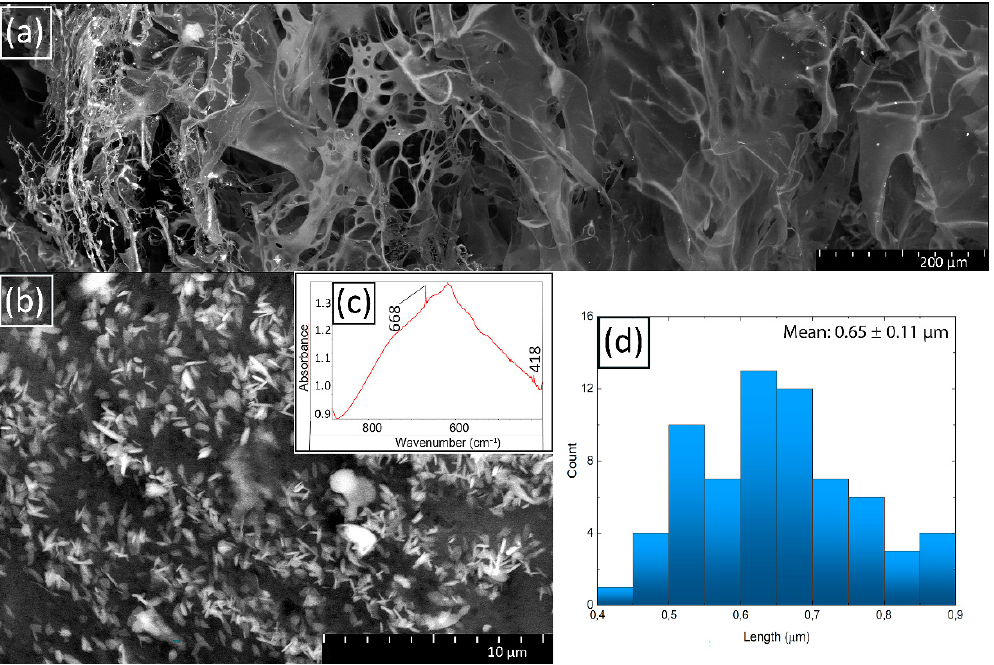
Figure 8. SEM-microphotographs of Cu/CS spherical gel sample (high molecular weight chitosan, 0.116 M, 300 µL) ( a ) cleavage; ( b ) surface; ( c ) part of FTIR spectra of Cu/CS spherical gel sample; ( d ) histogram of surface Cu crystal length distribution.